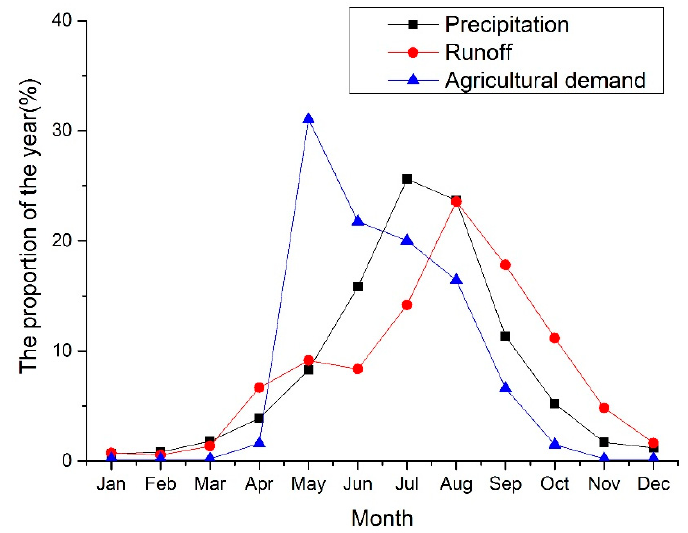
Figure 4. The intra-annual variation in the precipitation and agricultural water demand in the Nen River basin.